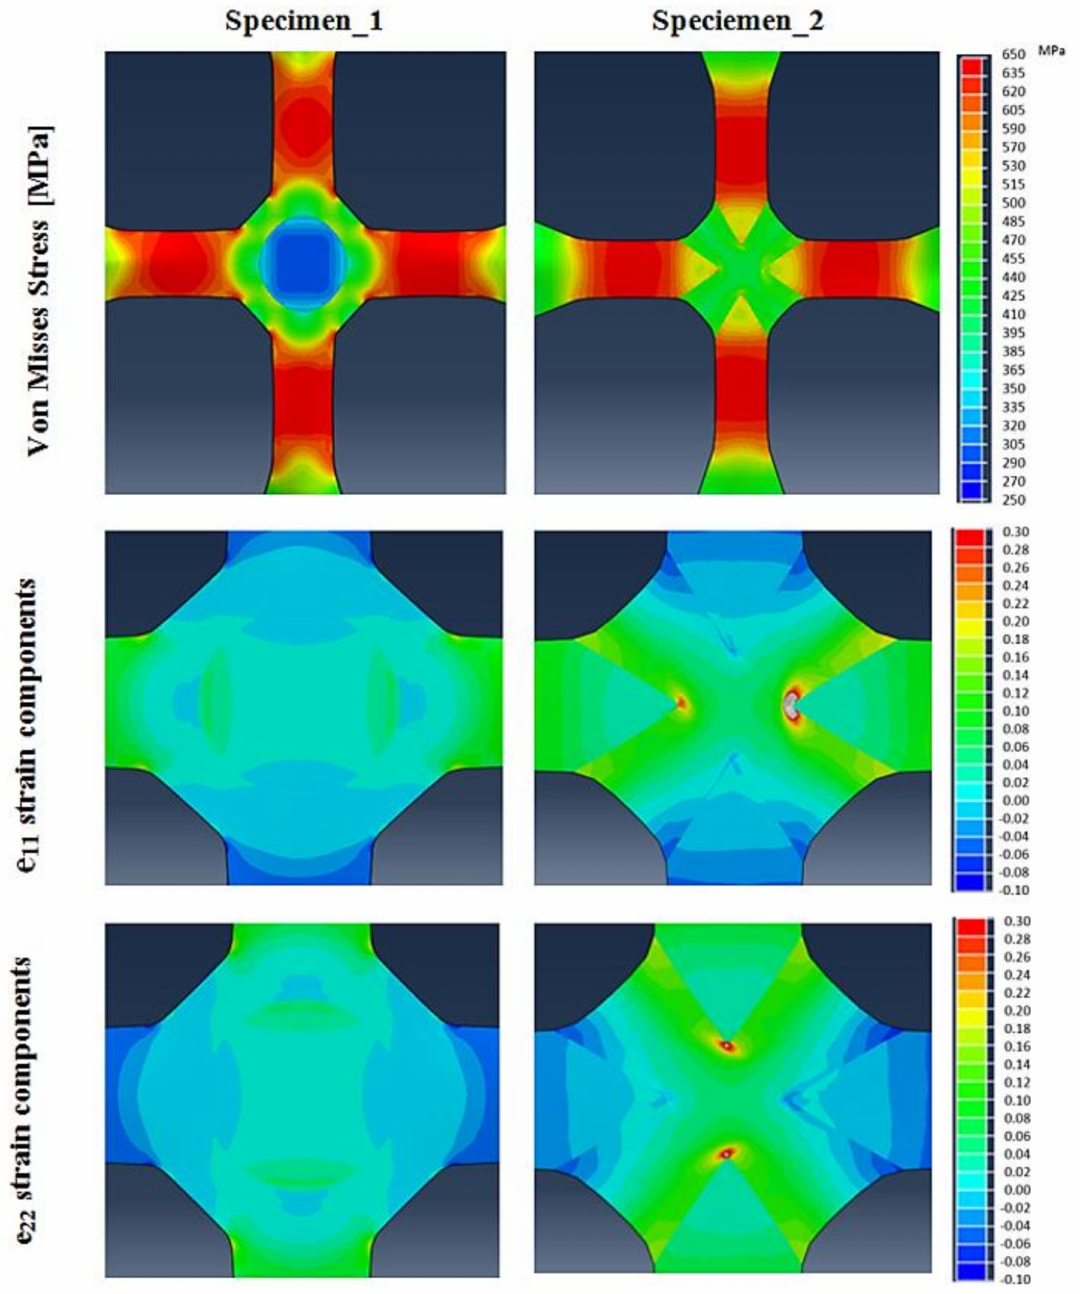
Figure 16. In-plane stress and strain components for Specimen_1 and Specimen_2 when the stress in the arms reached